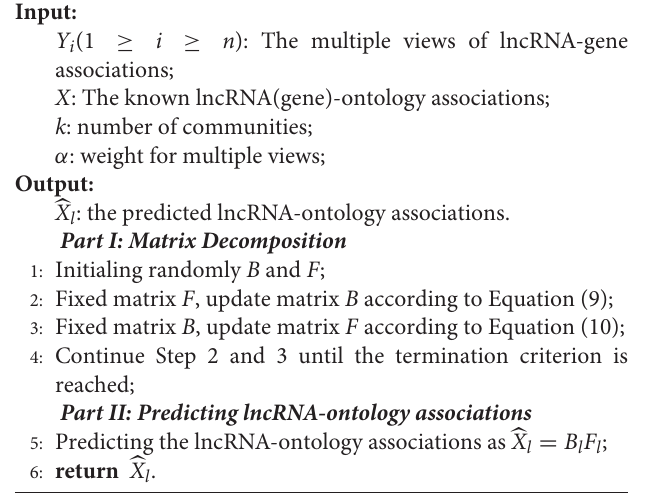
Algorithm 1 The MPrNMF